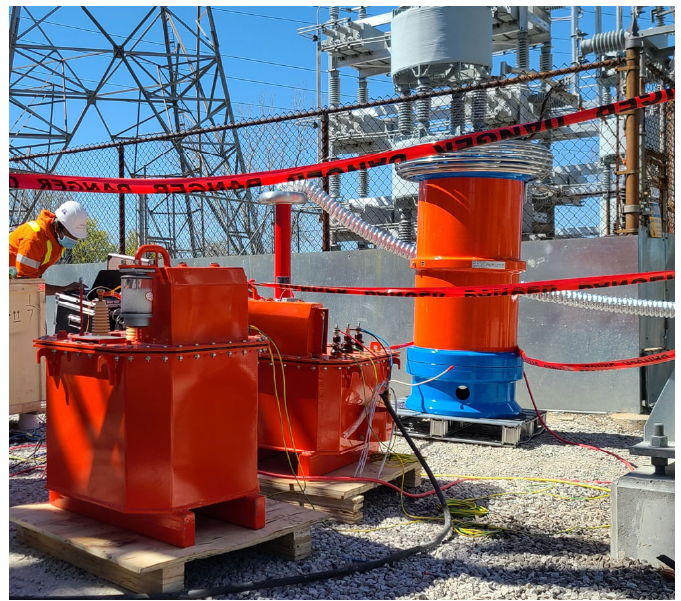
Figure 3. Example of a 70 kV/10A VFRSTS including an isolation transformer, inverter, step-up transformer, HV reactor, and coupling capacitor and used as HV power supply for on-site tests.